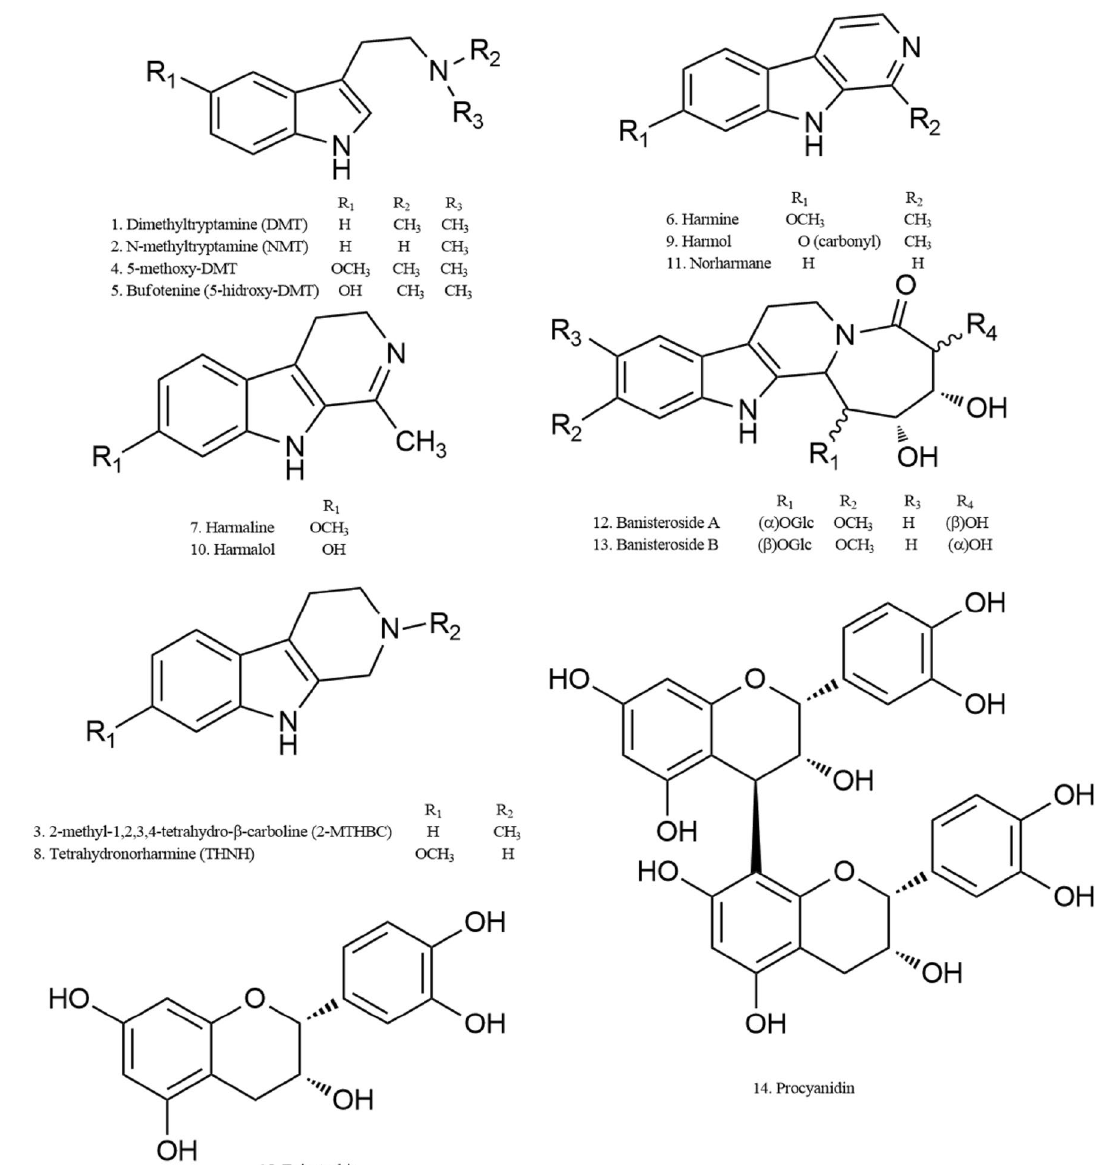
Fig. 3 Main compounds in P. viridis ( 1 - 5 ) and B. caapi ( 6 - 15